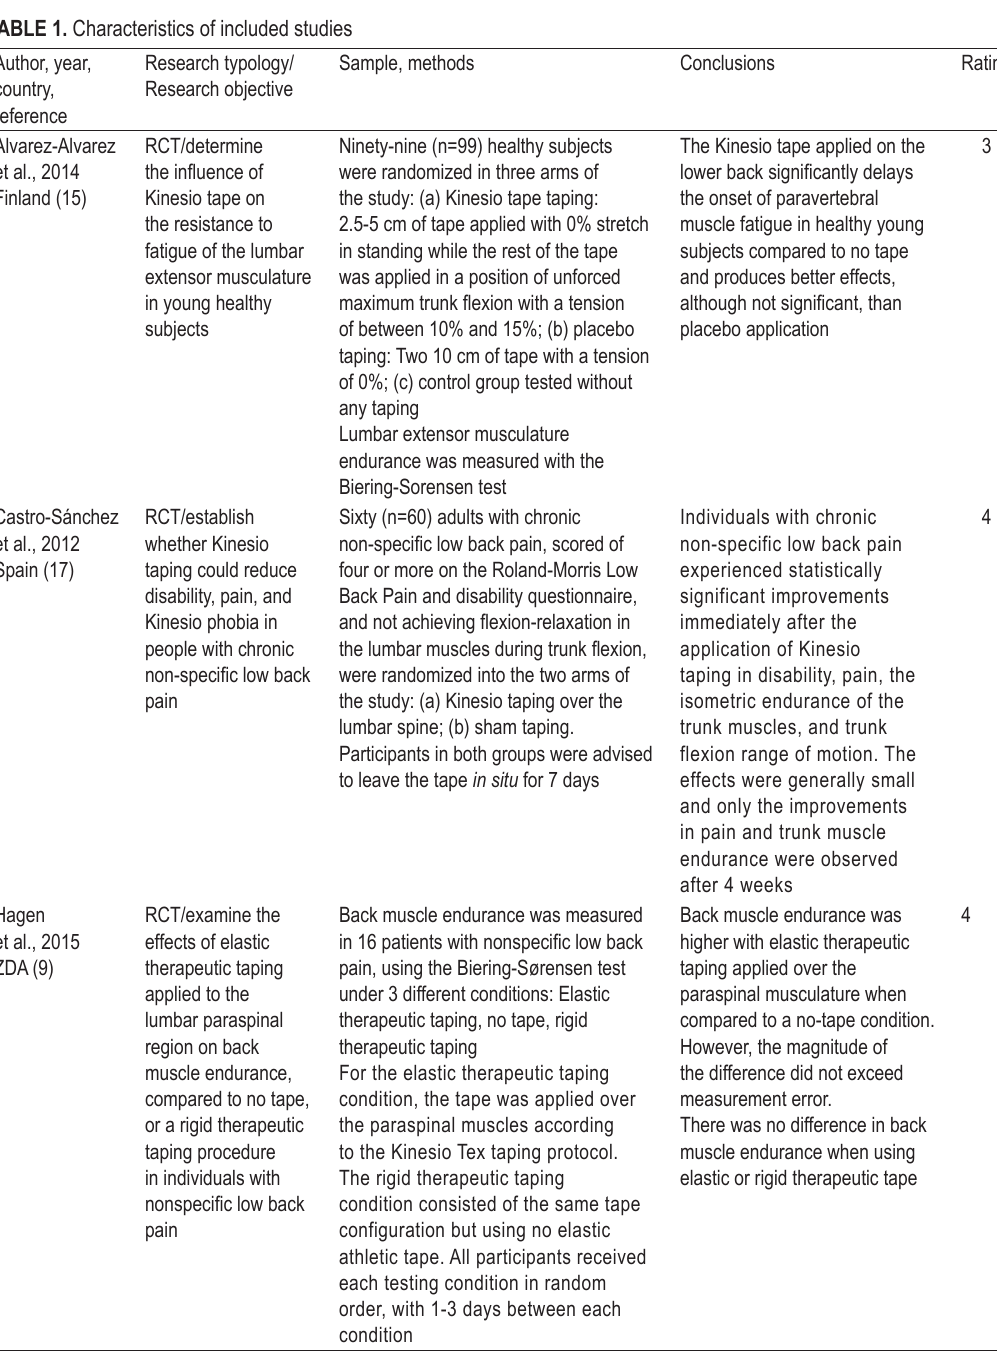
TABLE 1. Characteristics of included